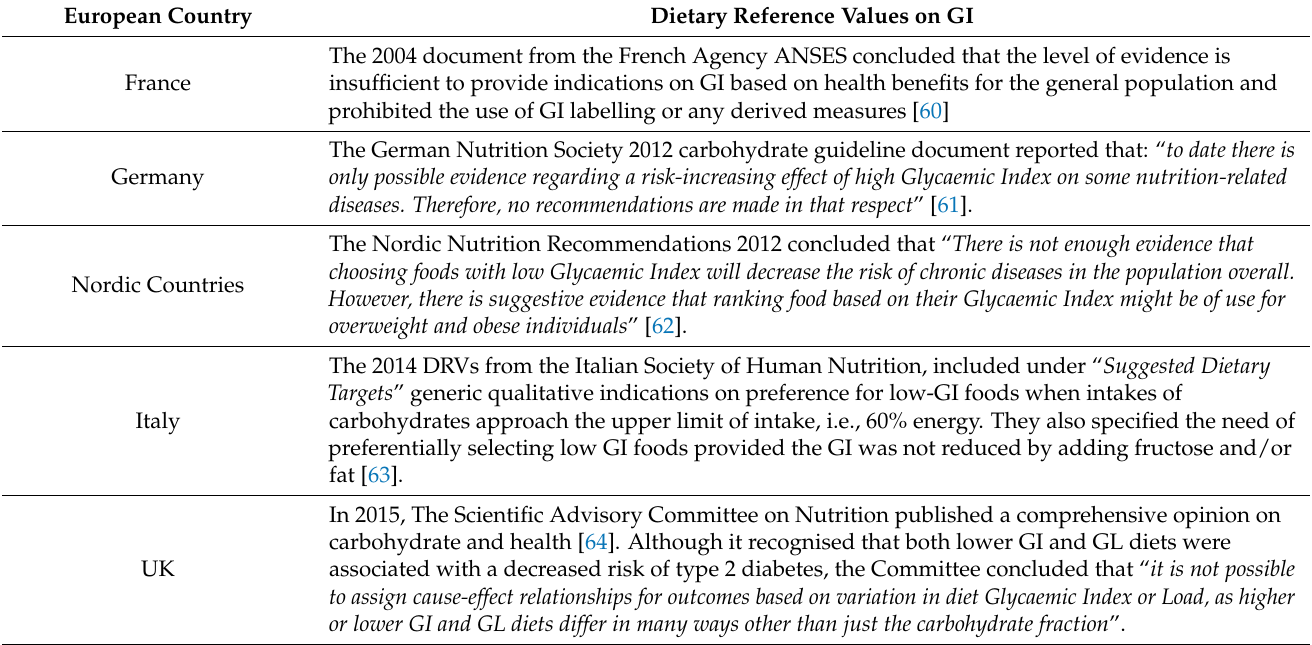
Table 4. Glycaemic index (GI) in European Dietary Reference Values (DRVs). Dietary Reference Values on